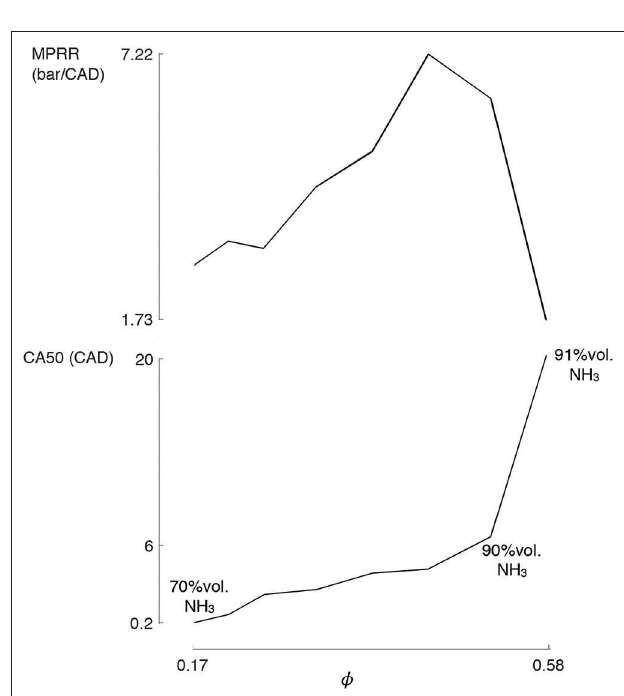
FIGURE 15 | MPRR and CA50 evolution for set #5: constant intake temperature and hydrogen flow rate for a continuously increased ammonia flow rate. The ammonia auto-ignition promotion by hydrogen stops suddenly at a threshold concentration, which depends on the operating pressure and temperature conditions.